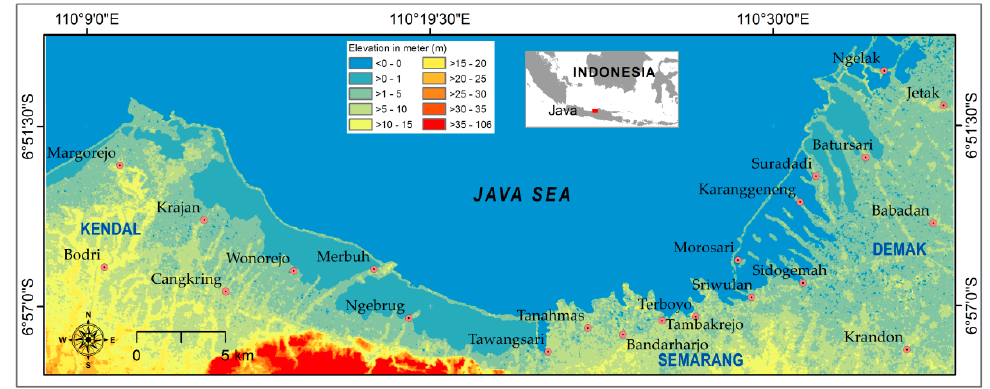
Figure 1. A part of the northern coast of Central Java Province selected as the study site. It is visualized by the topographic data from Shuttle Radar Topographic Mission (SRTM) showing the topography of the area and village locations referred to in the text.